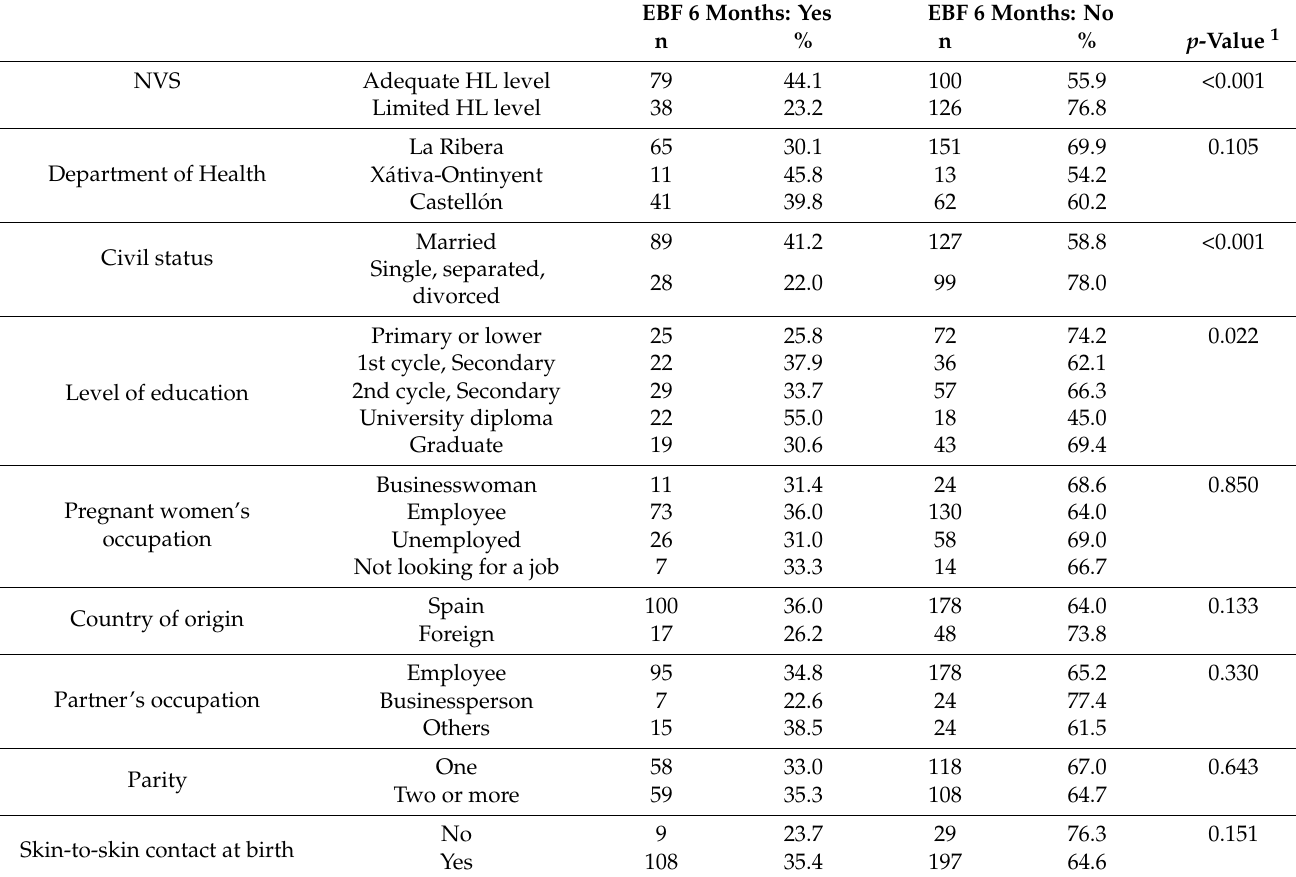
Table 3. Factors related to EBF cessation before 6 months.